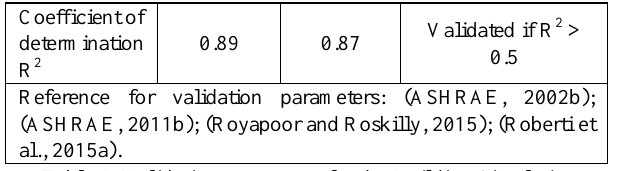
Table 1. Validation parameters for the Building